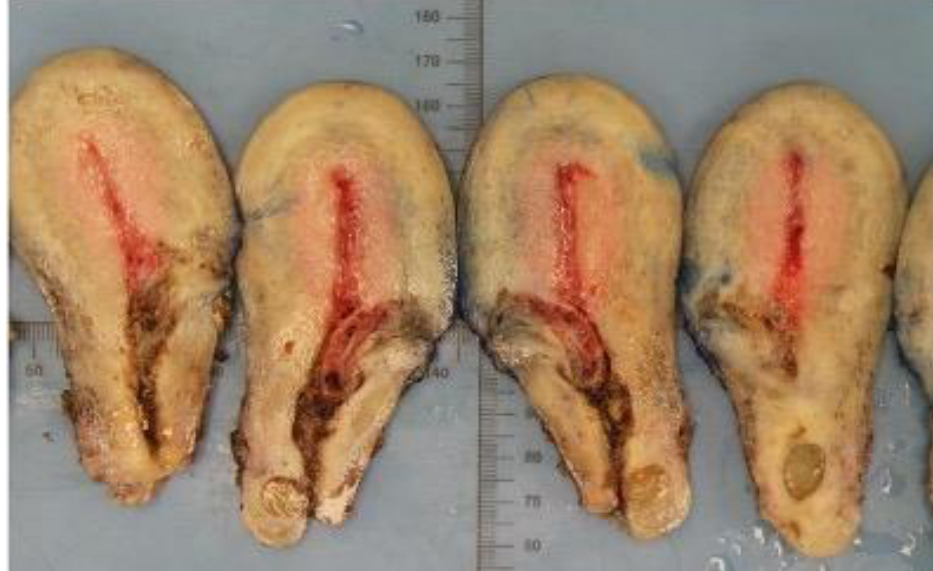
Figure 4. Histopathological hysterectomy specimen where invasive retained products of conception was present following medical termination of pregnancy. Photograph by Dr Danah Saif. was present following medical termination of pregnancy. Photograph by Dr. Danah